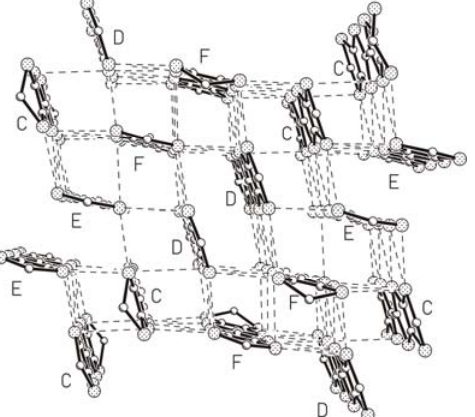
B H ) ] ( 3 ). 2 9 10.06 2